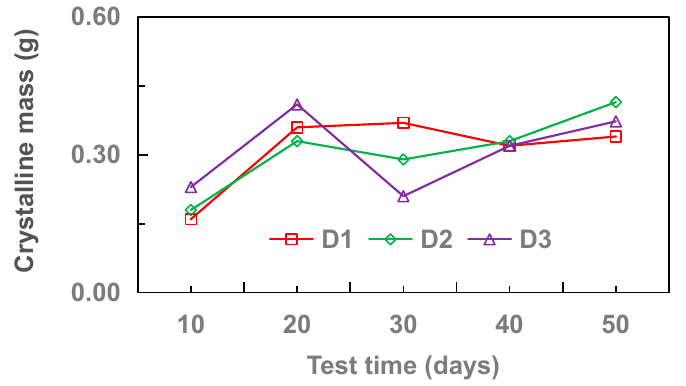
Figure 5. Variation of crystal quality with time.